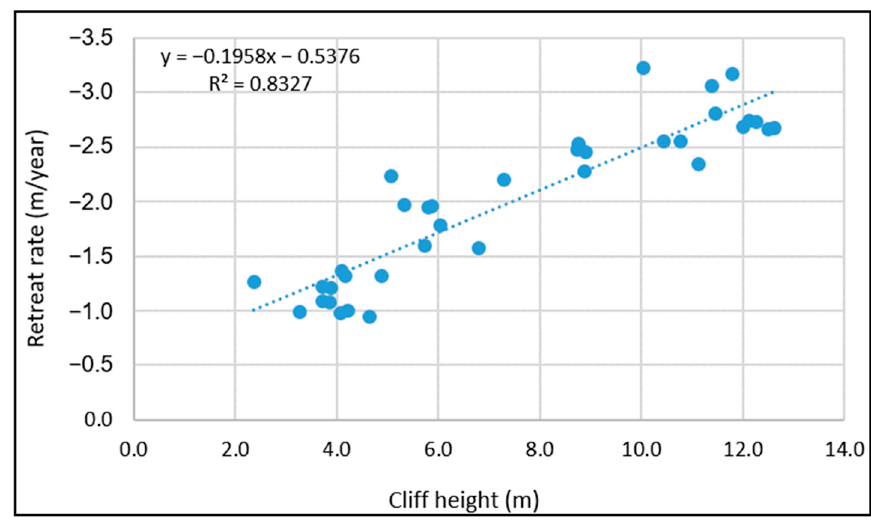
Figure 21. Relationship between retreat rates and cliff height at Rivière